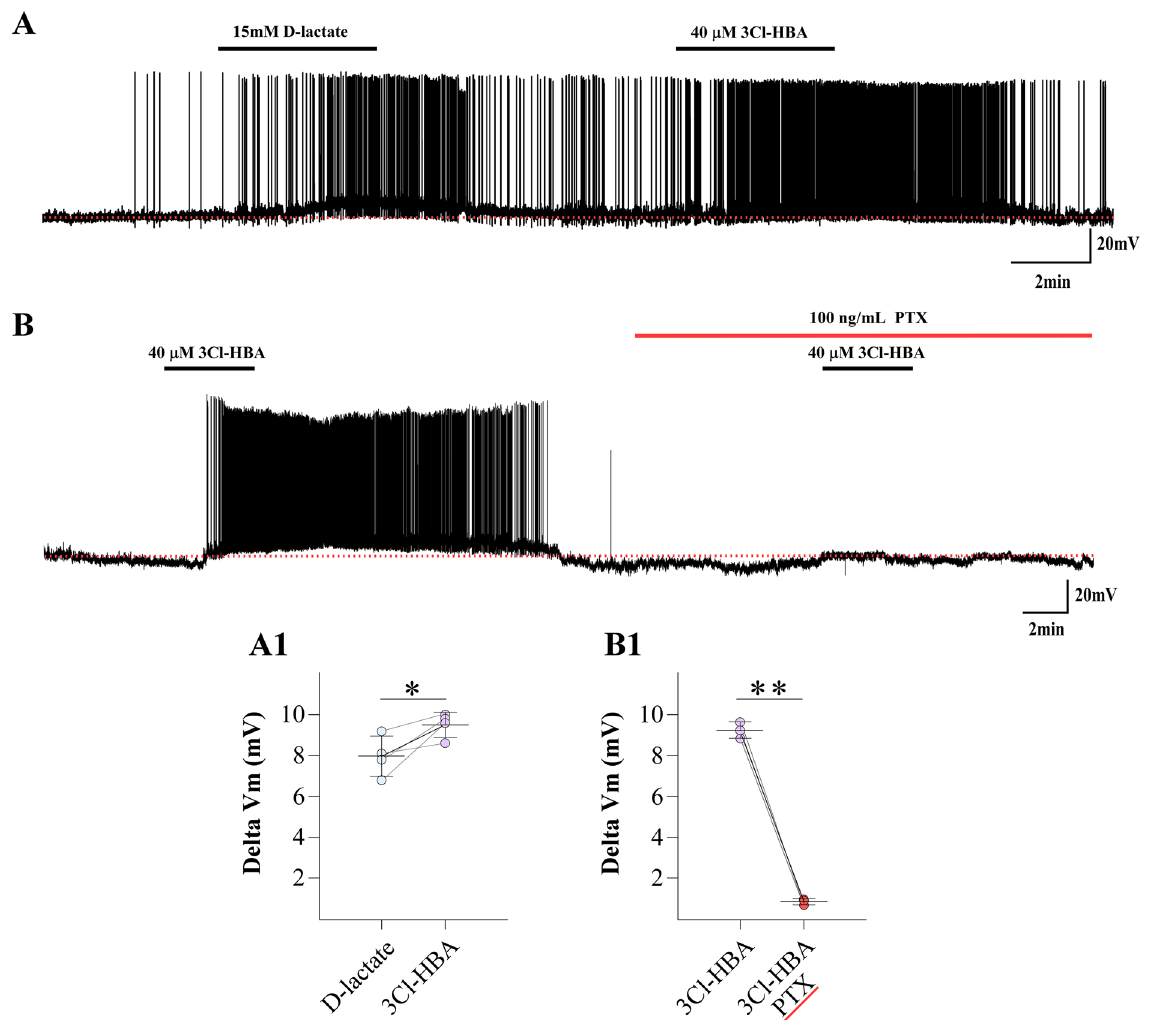
Figure 3. Activation of HCAR1 depolarizes POMC neurons. ( A ) POMC neurons excited by d-lactate (15 mM) were also depolarized in the presence of the HCAR1 agonist, 3Cl-HBA (40 µM). The resting membrane potential was − 54 mV. ( B ) The depolarization elicited by 3Cl-HBA was completely abolished by the Gαi protein inactivator (100 ng/mL PTX). The resting membrane potential was − 56 mV. ( A1–B1 ) Summary of the effects of d-lactate/3-Cl HBA and 3-Cl HBA/PTX on the membrane potential in POMC neurons. Baselines are shown with the red dotted